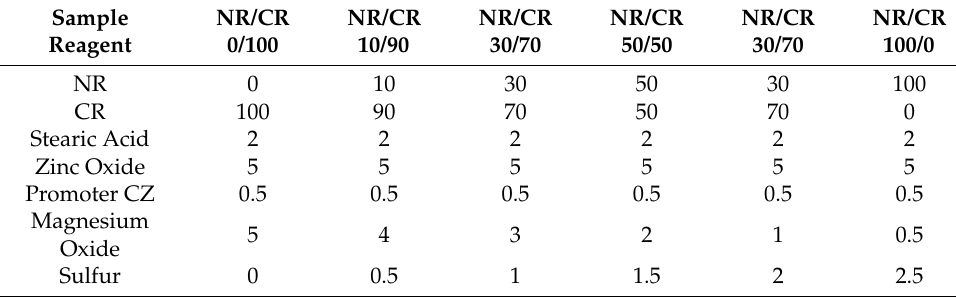
Table 3. Formulation of the NR/CR